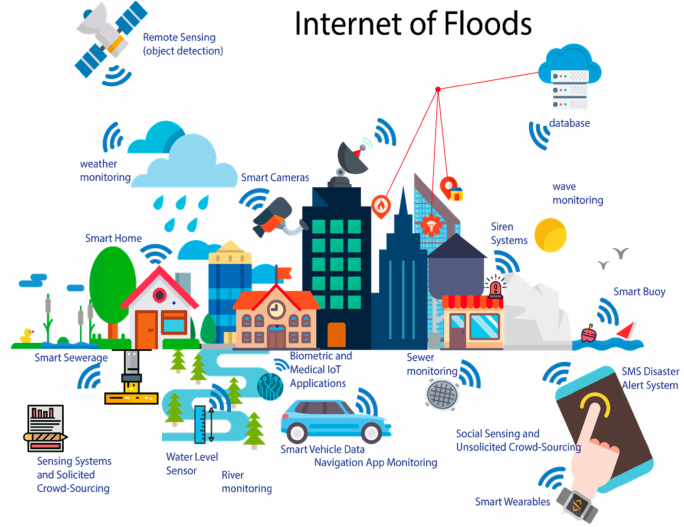
Figure 1. Schematic representation of the Internet of